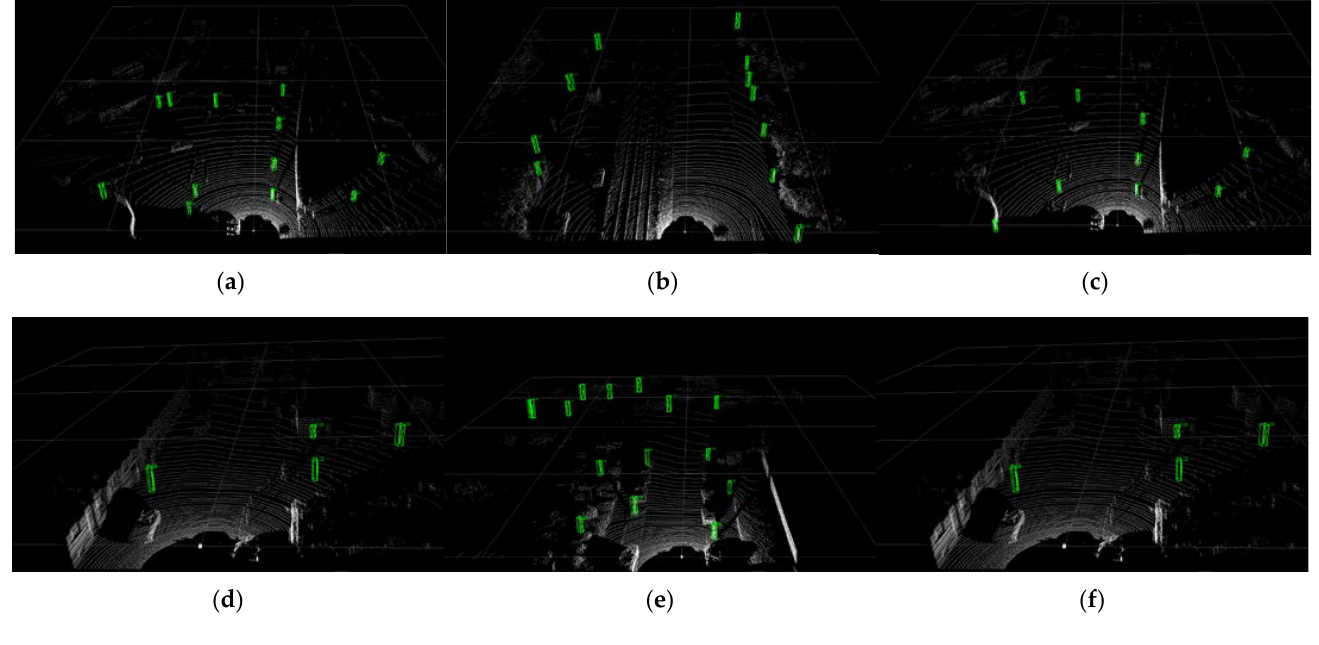
Figure 10. Test results of PointRCNN. ( a ) Three-dimensional view of the ( c ); ( b ) Three-dimensional view of the ( d ); ( c ) camera image; ( d ) camera image.